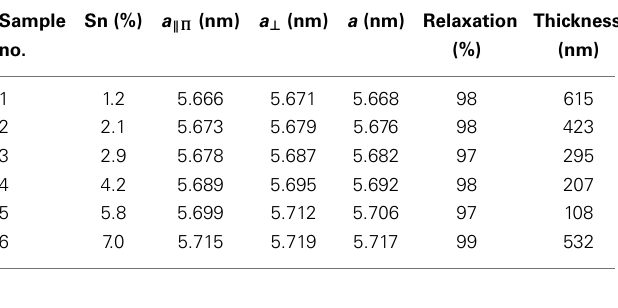
Table 2 |Tin mole fraction calculation, lattice constant, and relaxation percentage of the grown samples